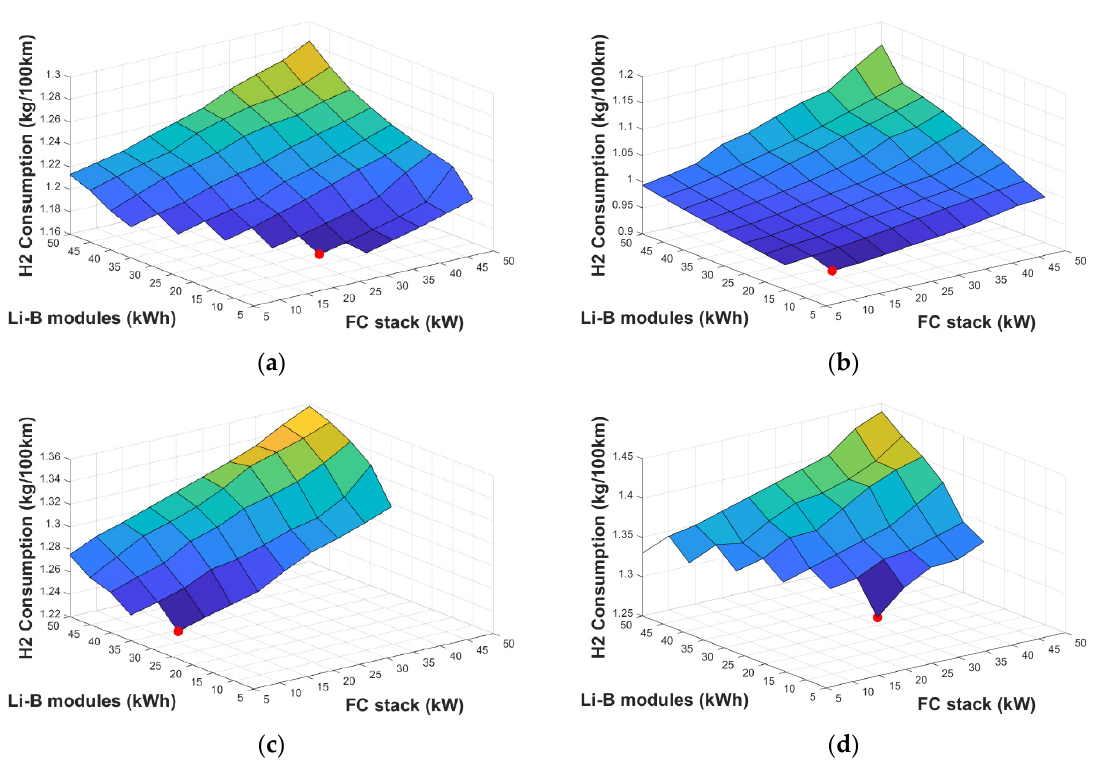
Figure 15. Fuel consumption of the FCV (Psplit2: δ = 1): ( a ) SFUDS, ( b ) FUDS, (c) NEDC, and (d) WLTP.